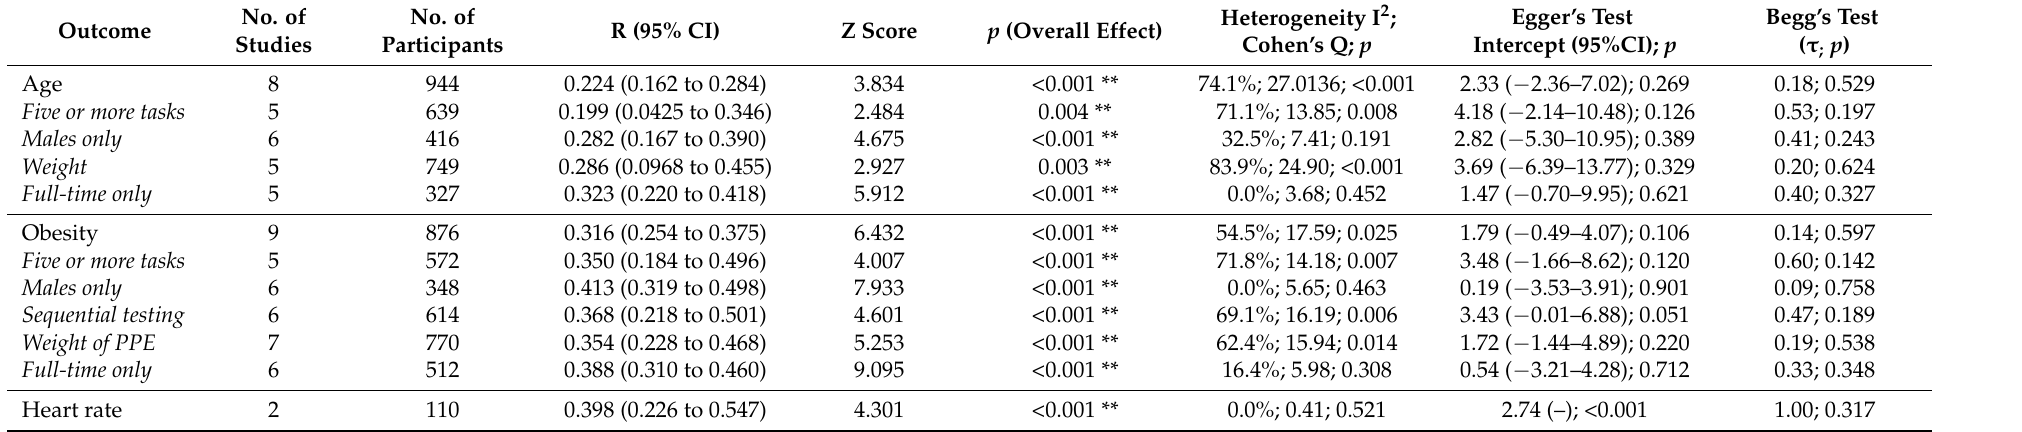
Table 4. The correlation between age, obesity and heart rate and occupational task performance in